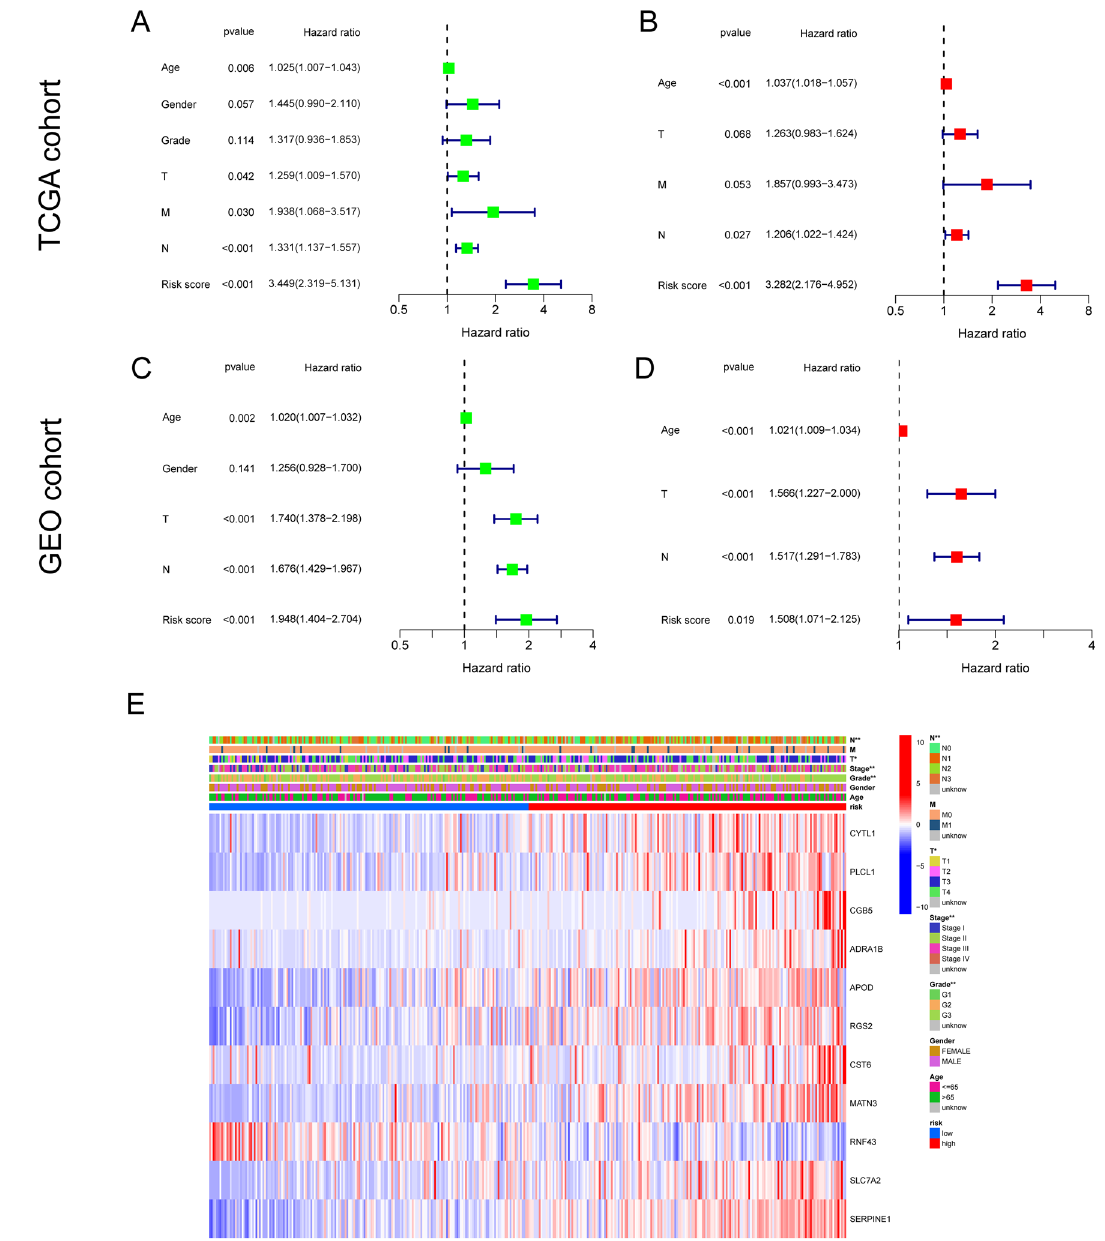
Figure 8. Independent prognosis analysis. ( A , B ) Univariate Cox regression analysis in the TCGA-GC cohort. ( C , D ) Multivariate Cox regression analysis in the GSE84437 cohort. ( E ) Heatmap depicting the clinicopathological characteristics and optimal genes expression between the high- and low-risk groups. Risk, age, gender, grade and stage were used as patient annotations. Red represents high expression and blue low expression. * p < 0.05; ** p < 0.01; *** p <